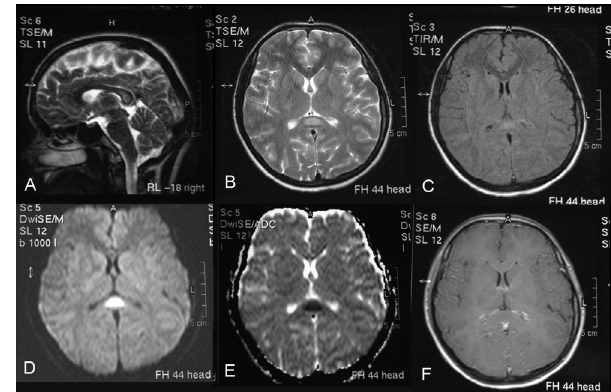
Figure 1 - Sagittal T2-weighted image (a), transverse T2-weighted image (b), transverse FLAIR image (c), and diffusion-weighted image (d) showing a high-intensity signal in the splenium of the corpus callosum. Transverse apparent diffusion coefficient image (e) showing a low-intensity signal in the splenium of the corpus callosum. Contrast transverse T1-weighted image showing only some slight contrast enhancement of the leptomeninges (f)